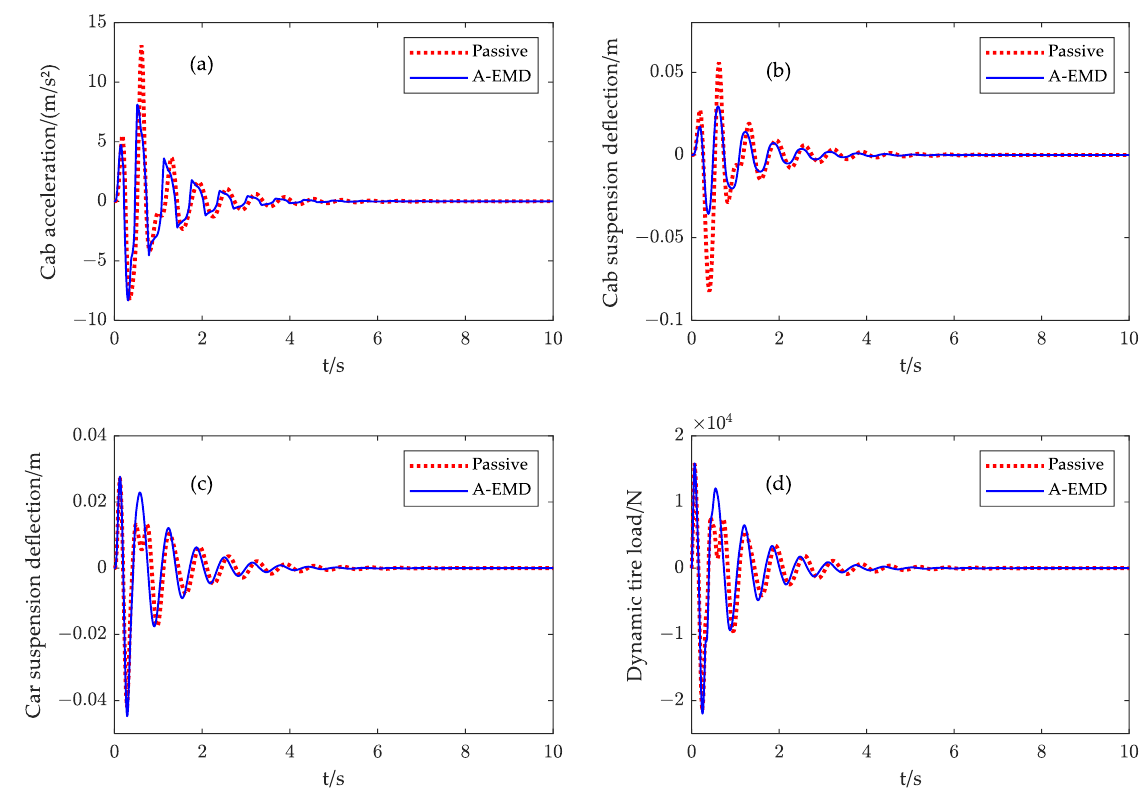
Figure 14. Response under bump road excitation: ( a ) cab acceleration; ( b ) cab suspension deflection; ( c ) car suspension deflection; ( d ) dynamic tire load.